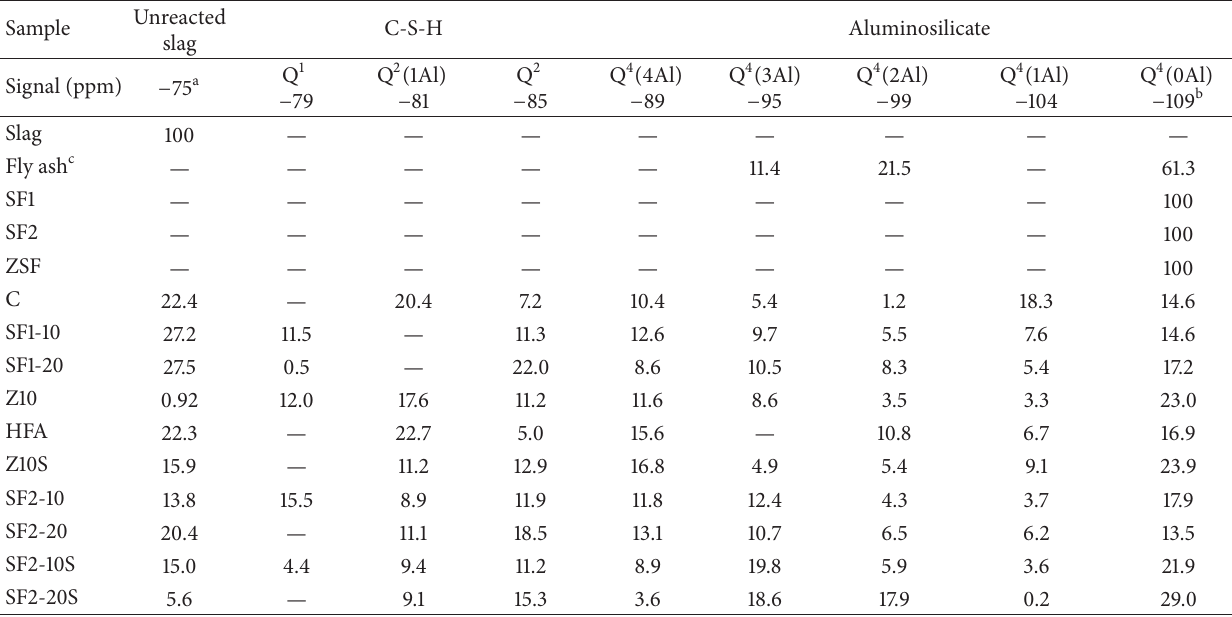
Figure 3: 29 Si NMR spectra and deconvolution of fly ash-slag geopolymers. Table 4: Area obtained from deconvolution results and peak analysis of 29 Si NMR spectroscopy